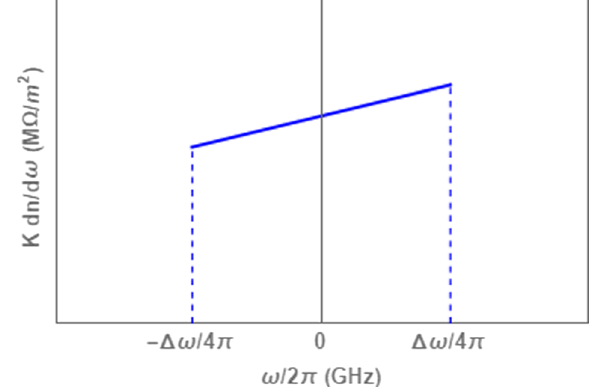
FIG. 23. The profile of the quantity K d n= d ω for a linear tapered structure which is to be Fourier transformed to find the wakefield.